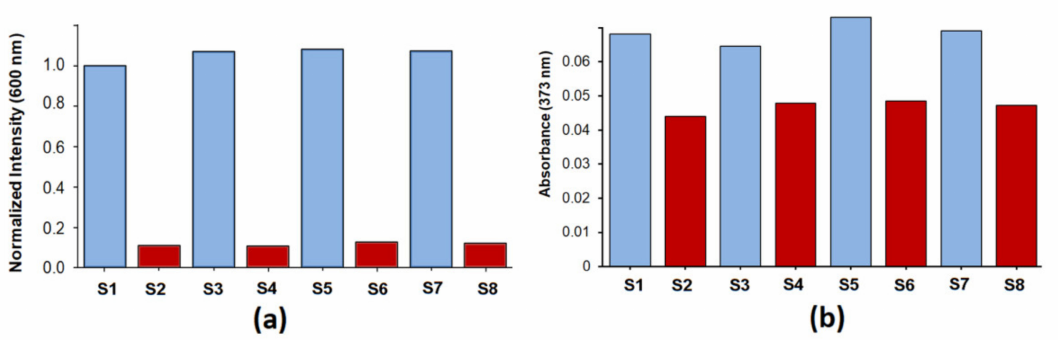
Figure 5. Cross-selectivity studies of metal ion binding by the ligand Ru(N 2 P 2 phen) ([ Ru(N 2 P 2 phen) ] = 5.4 µ M, pH = 7.4, [HEPES] = 0.03 M, and λ ex = 450 nm) using fluorescence spectroscopy ( a ) and electronic absorption spectroscopy ( b ): (S1) intensity at 600 nm ( a ) and